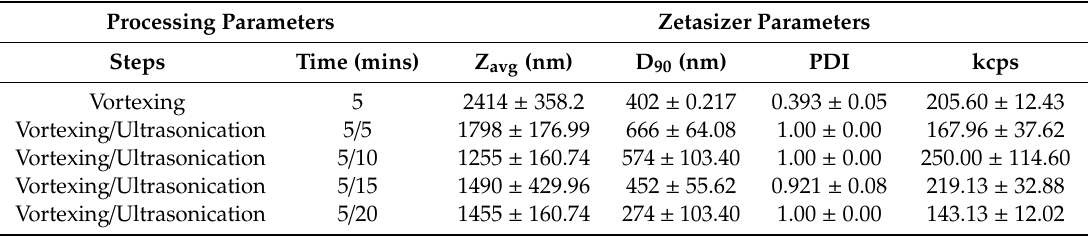
Table 4. Impact of critical process parameters of CEL_NCSD for size determination of embedded nanocrystals of CEL using Zetasizer. The values are the average of six measurements (Mean ±